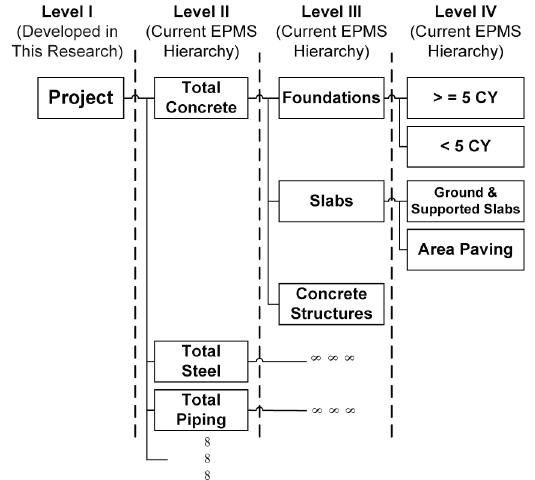
Fig. 1. The EPMS metric